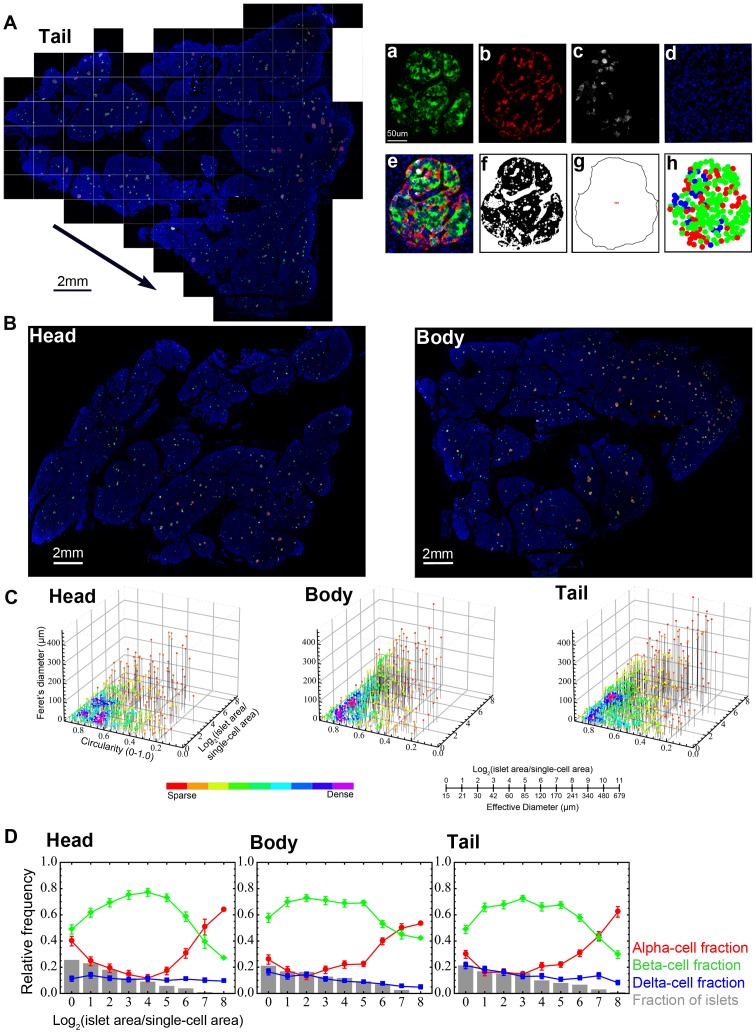
Large-scale image capture and computer-assisted semi-automated analysis of the whole tissue section.
A: Virtual slice view of a human pancreatic section (tail region; ND21: 59-yr old male) immunostained for insulin (green), glucagon (red), somatostatin (white) and nuclei (blue). A series of contiguous images of a specimen is collected (illustrated as boxed panels) and merged into a single image montage (i.e. virtual slice; arrowed). A composite is made by merging four overlapping virtual slice images. Regional views of each channel are shown on the right. a. beta-cells, b. alpha-cells, c. delta-cells, and d. nuclei. e. A composite of all three endocrine cells and nuclei. Note that there is no overlap among the endocrine cell fractions. f. Total endocrine cell area shown as a converted 8-bit mask after automatic thresholding. g. Total islet area that includes unstained fractions such as intraislet capillary. h. Reconstructed endocrine cell distribution within each islet based on the captured center coordinates of each cell type within the given islet, which can be used to count the number of each endocrine cell type and analyze cellular composition and geographic islet architecture. B: Virtual slice views of the head and body region. C: Three-dimensional visualization of islet size (area) and shape (circularity and Feret's diameter) distribution in the head, body and tail region. Each dot represents a single islet/cluster. The density of islets is color-coded from sparse to dense. The conversion between logarithmic islet area and effective diameter (µm) is shown. D: Quantitative analysis of individual islet size distribution and cellular composition. Relative frequency of islet size (gray bar) and ratios of beta (green), alpha (red), and delta (blue) cells within islets are plotted against islet size; means ±SEM.